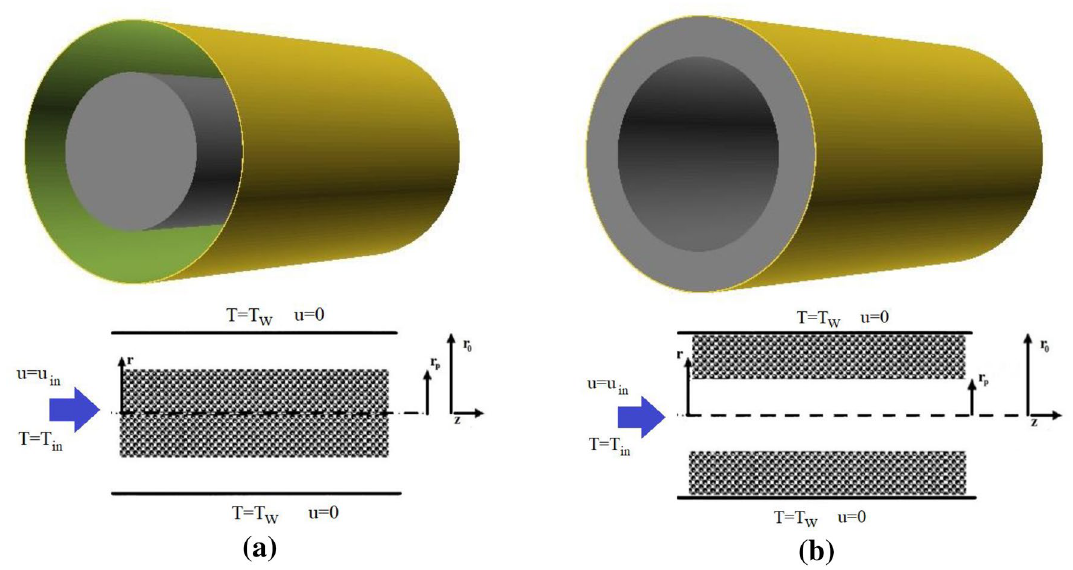
Fig. 1 Porous media configurations: a central arrangement b boundary